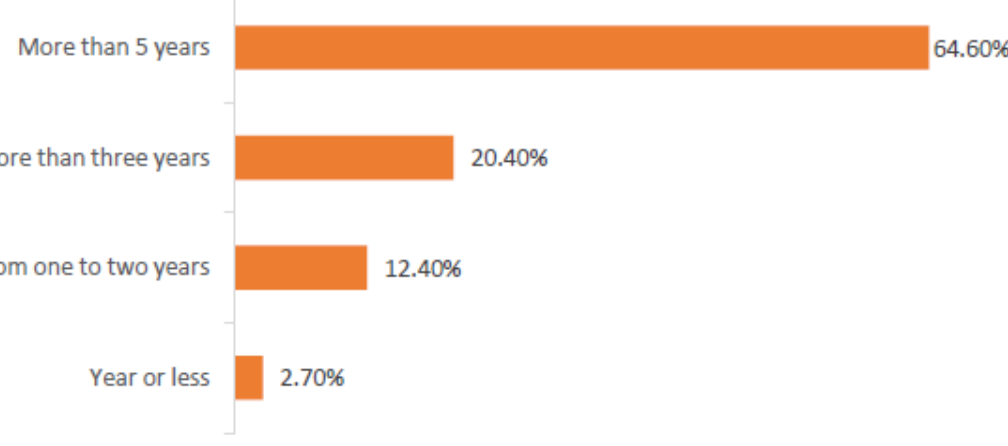
Figure 2. The relationship Between Using of Steroids and Years of Practice.